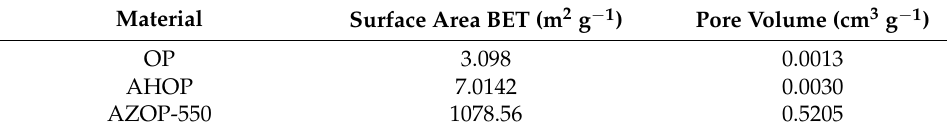
Table 1. Textural properties of the adsorbent materials under study.